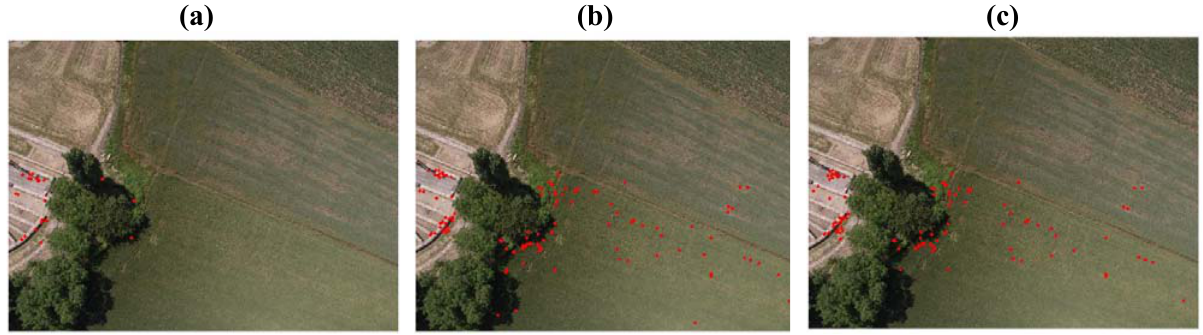
Figure 8. Comparative test. Image correspondences automatically matched (L=10) by SIFT with